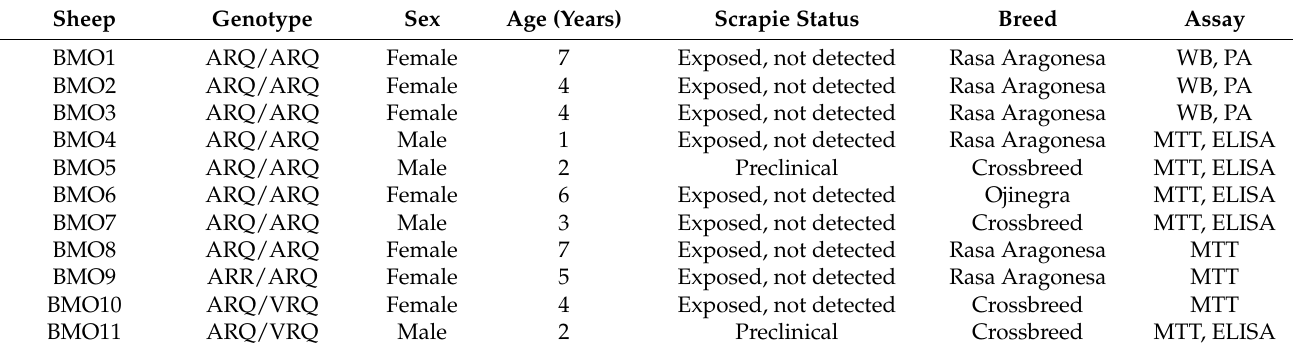
Table 1. Characteristics of the animals selected to obtain bone marrow mesenchymal stem cells. The different assays in which the ovine bone marrow-derived mesenchymal stem cells (oBM-MSCs) were used, are also shown—Western blotting assay (WB), proliferation assay (PA), cell viability assay (MTT) and ELISA.